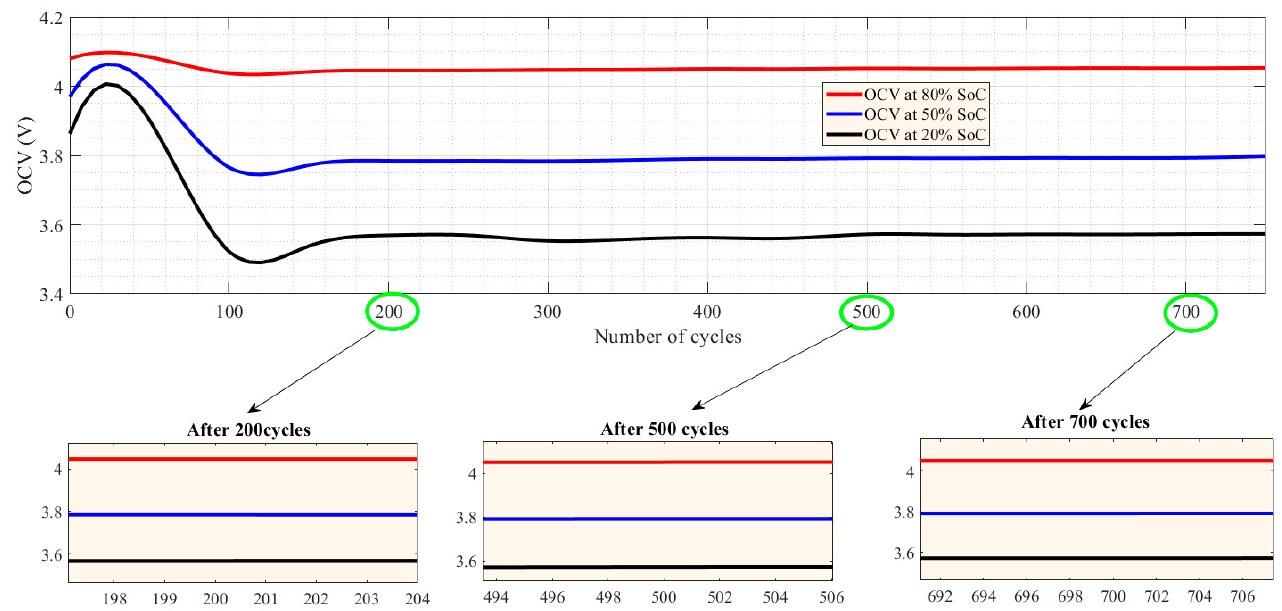
Figure 13. Comparison of the OCV pattern at 25 °C under C/2 charge and 4C discharge test conditions.